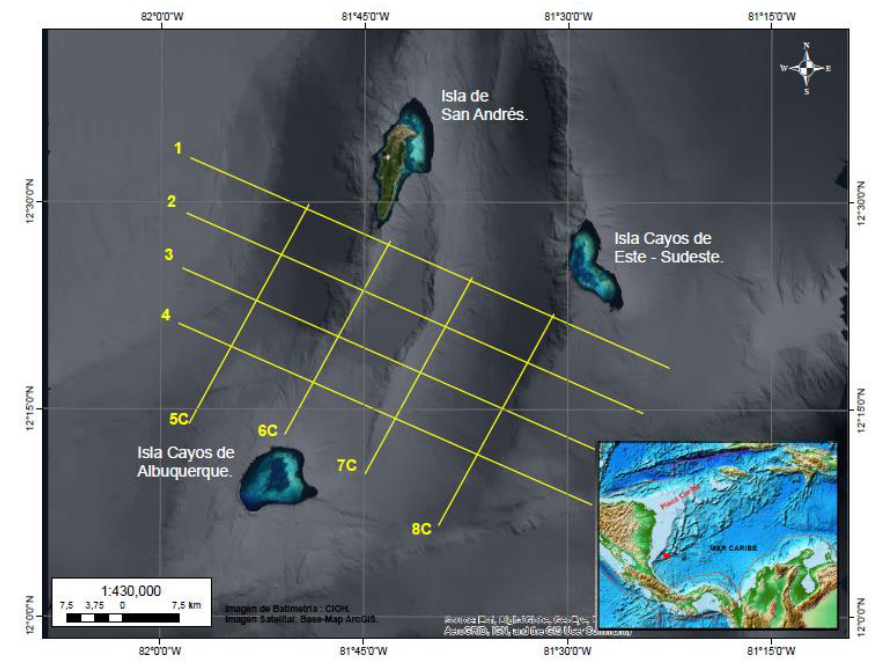
Figure 3. Lines of survey. Table 1. Estimation of duration of the survey in days from linear nautical Table 1. Estimation of duration of the survey in days from linear nautical miles. miles.